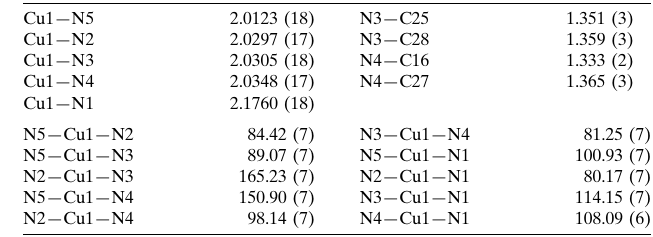
Selected geometric parameters (A˚ , (cid:3) ).